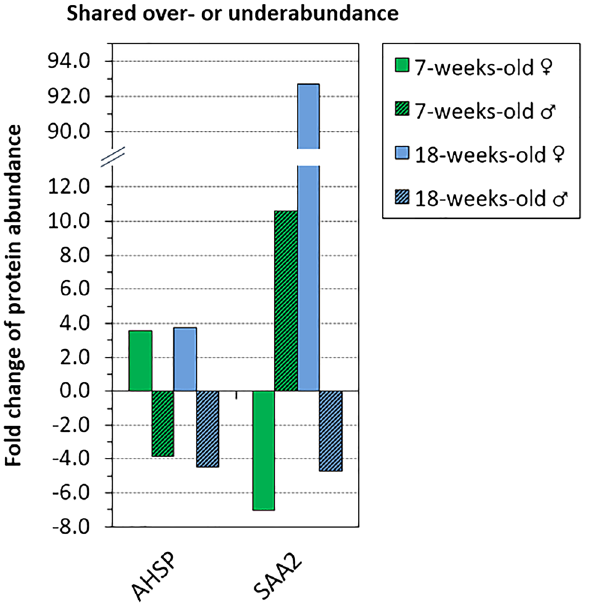
Figure 2. High-abundance change proteins shared between all age and sex groups. Twenty-four hours after 0.5 Gy total body irradiation, only two differentially abundant proteins with a fold change (FC) value |FC|≥ 3 were shared between female ( ♀ , solid fill) and male ( ♂ hashed) C57BL/6 N mice at juvenile (7-weeks-old, green) and adult (18-weeks-old, blue) age in blood plasma. Alpha hemoglobin stabilizing protein (AHSP) showed similar FC values across age after irradiation, but inverted abundance across sex. Serum amyloid A-2 protein (SAA2) showed large FC variance across both age and sex. Please note that presented data is normalized to respective unirradiated control